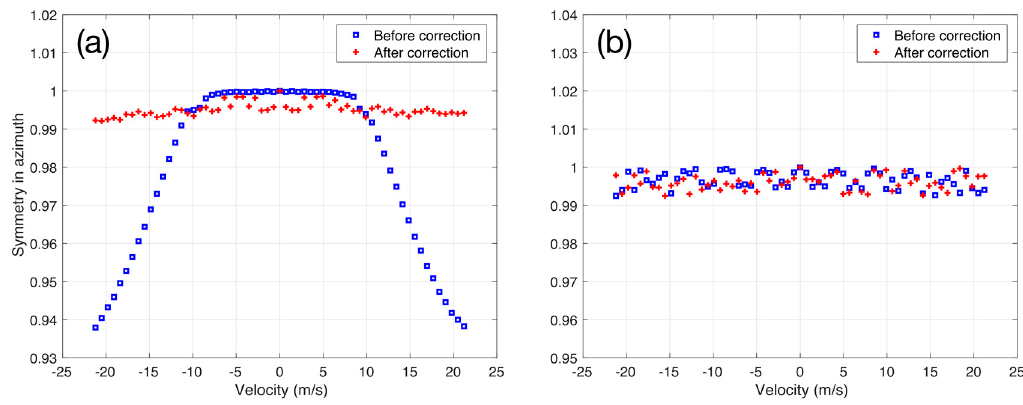
Figure 5. Simulation results of ( a ) azimuth and ( b ) range symmetry of the reconstructed signals. While the range symmetry was not seriously affected by the target’s moving speed, the azimuthal symmetry deteriorated when the moving speed was higher than 8 m/s. The azimuthal symmetry is well recovered by the proposed method as in ( a ).